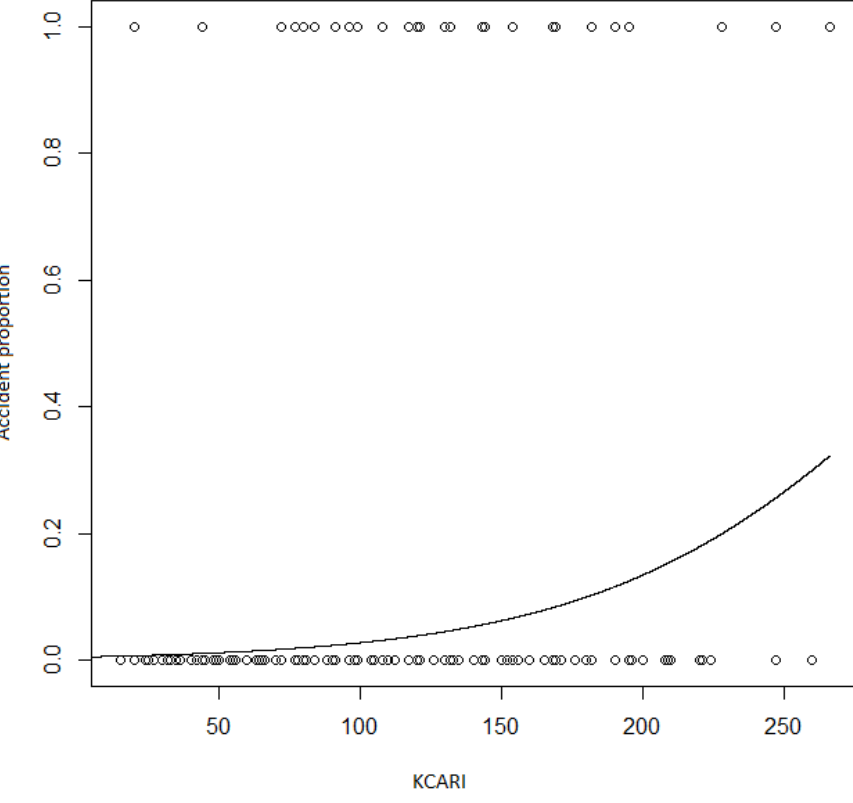
Figure 4. The accident proportion by KCARI.